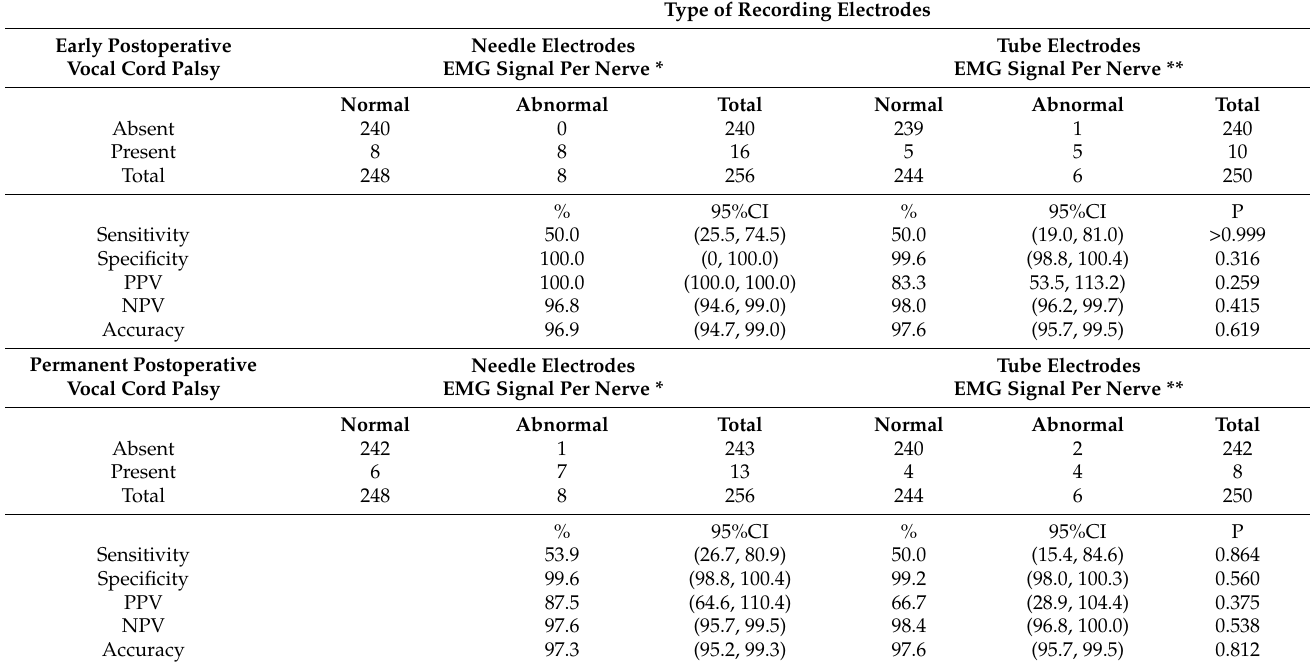
Table 6. Prediction of early and permanent postoperative vocal cord palsy by type of recording